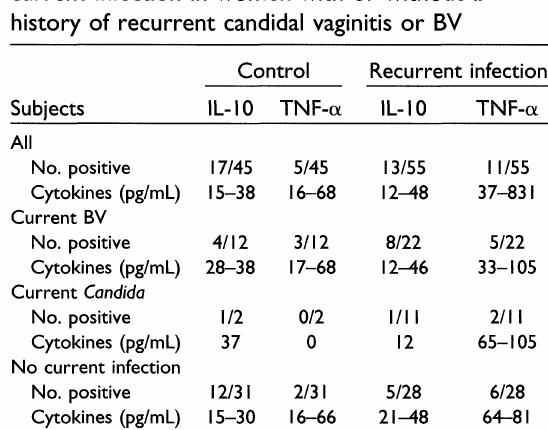
Fig. I. Circulating heat shock proteins in women with a history of recurrent vaginal infections, with or without a current vaginal infection. Sera from 55 women with current candidal infection or BV were tested for hsp60 and hsp70 by ELISA. Values were converted to IJg/mL by reference to a standard curve. Six women were positive for both Candida and BV. The horizontal line indicates the mean value. TABLE 3. Cytokine production in relation to current infection in women with or without